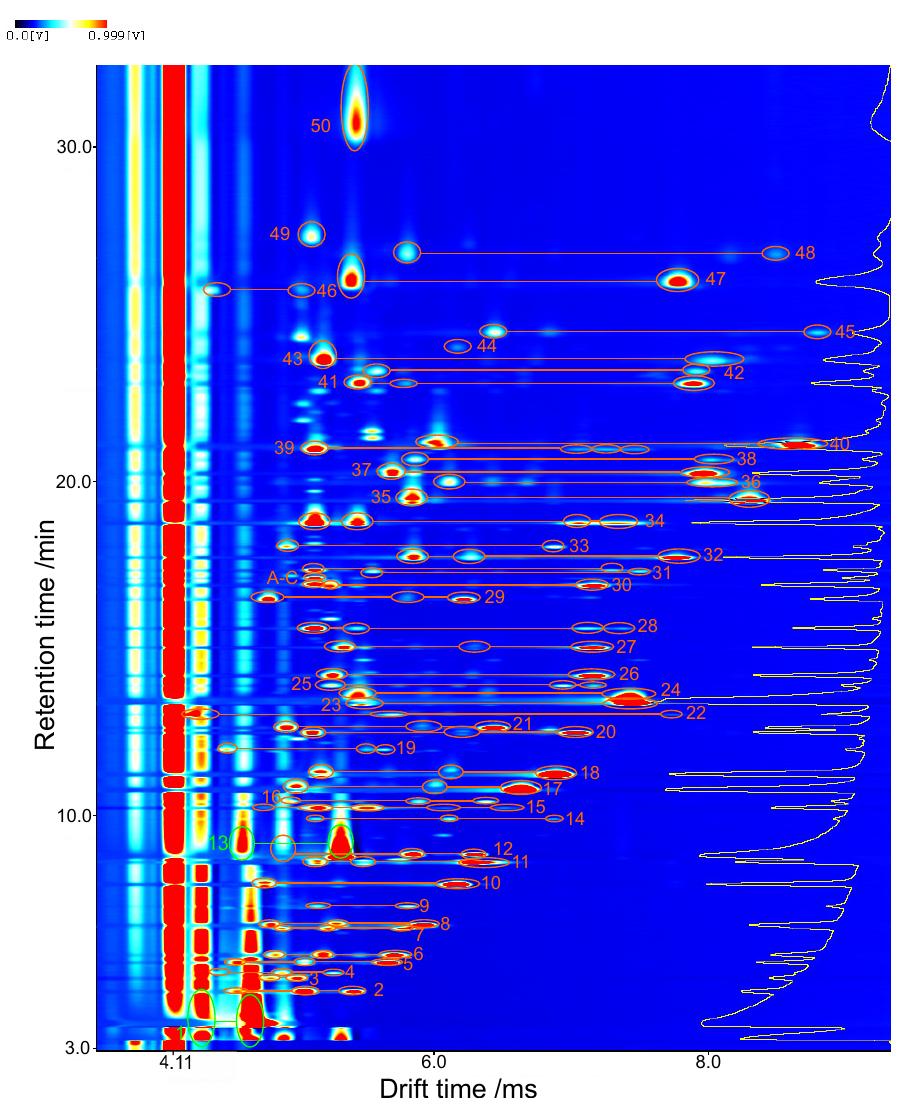
Figure 2. Partial GCxIMS plot of a banana-flavored nicotine-free e-liquid spiked with approximately 13 µg/g of 29 different flavor compounds. The corresponding monomer, dimer, and mixed dimer signals of all identified substances are labeled and connected with the substance names listed in Table